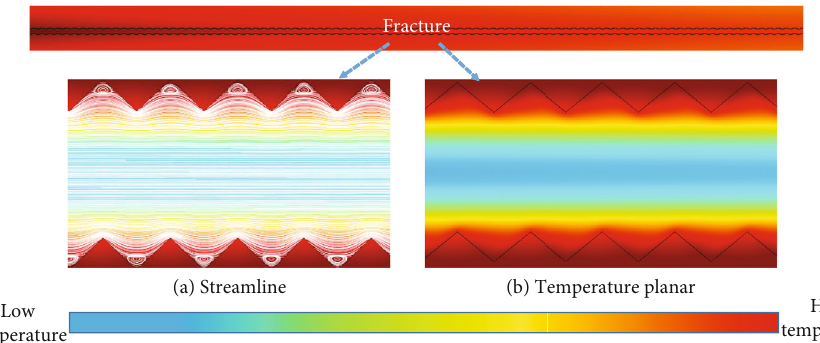
Figure 10: Local temperature distribution of